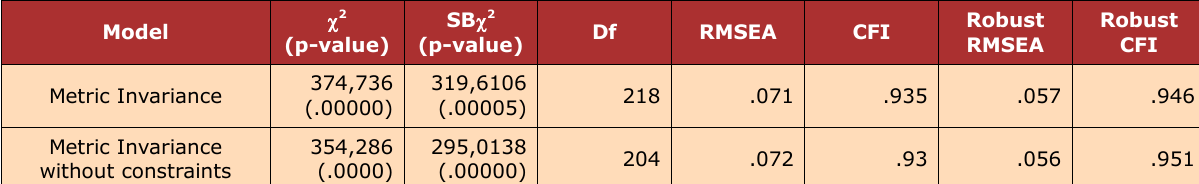
Table 4. Goodness of fit indexes for metric